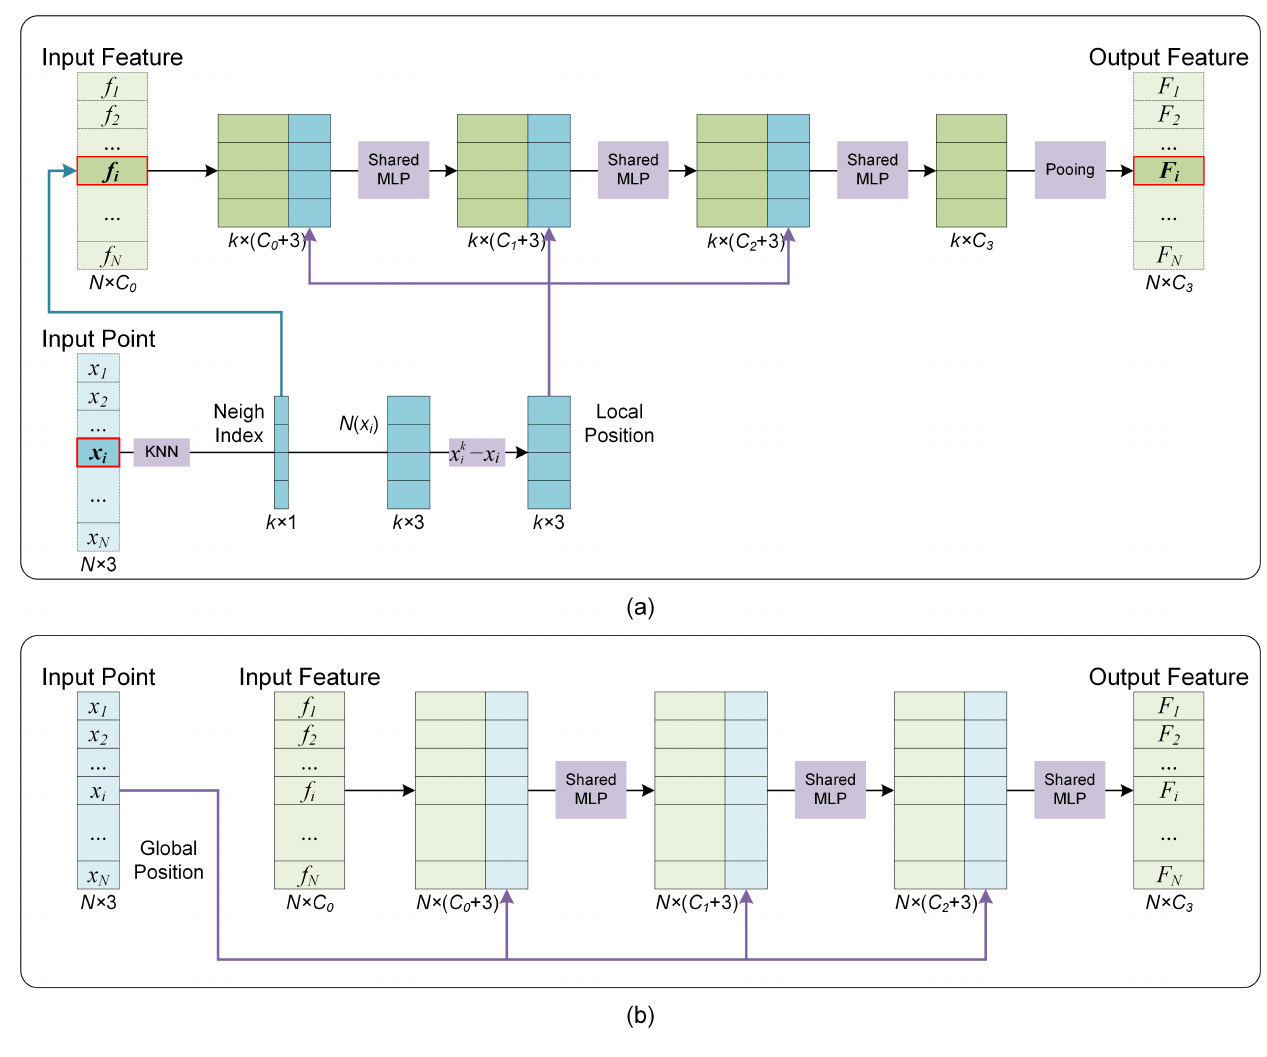
Figure 4. The Fusion Modules corresponding to local ( a ) and global ( b ) perception